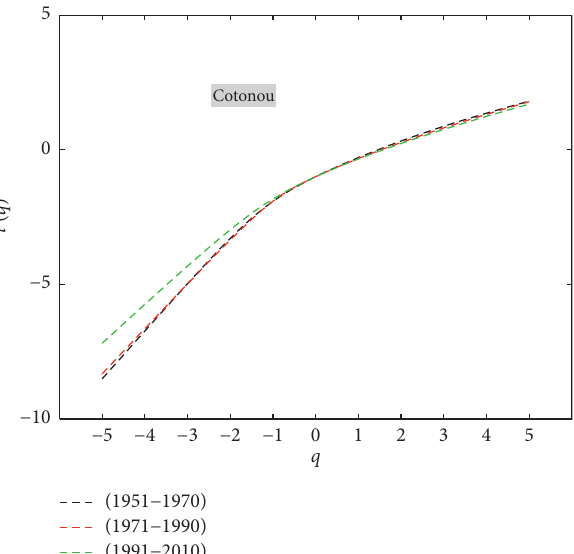
Figure 6: Plot of scaling exponent with moment order ( τ ( q ) versus ( q ) of Cotonou synoptic station precipitation time series: 1951–1970 (black color), 1971–1990 (red color), and 1991–2010 (green color).